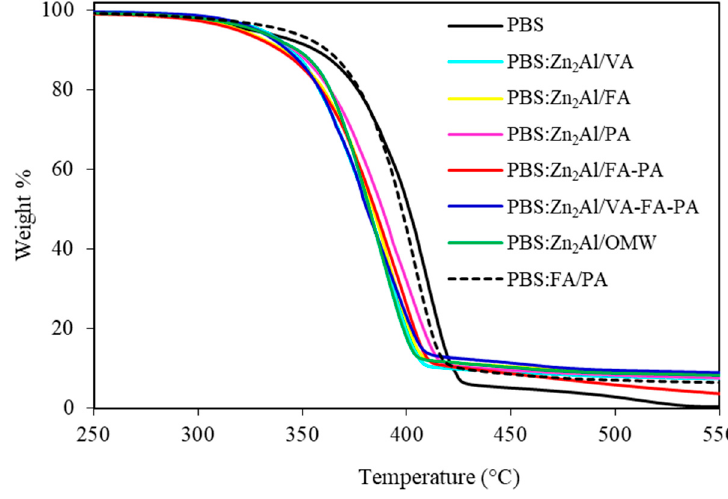
Figure 2. TGA profiles of PBS, PBS:FA/PA, and PBS:Zn 2 Al/X composites.